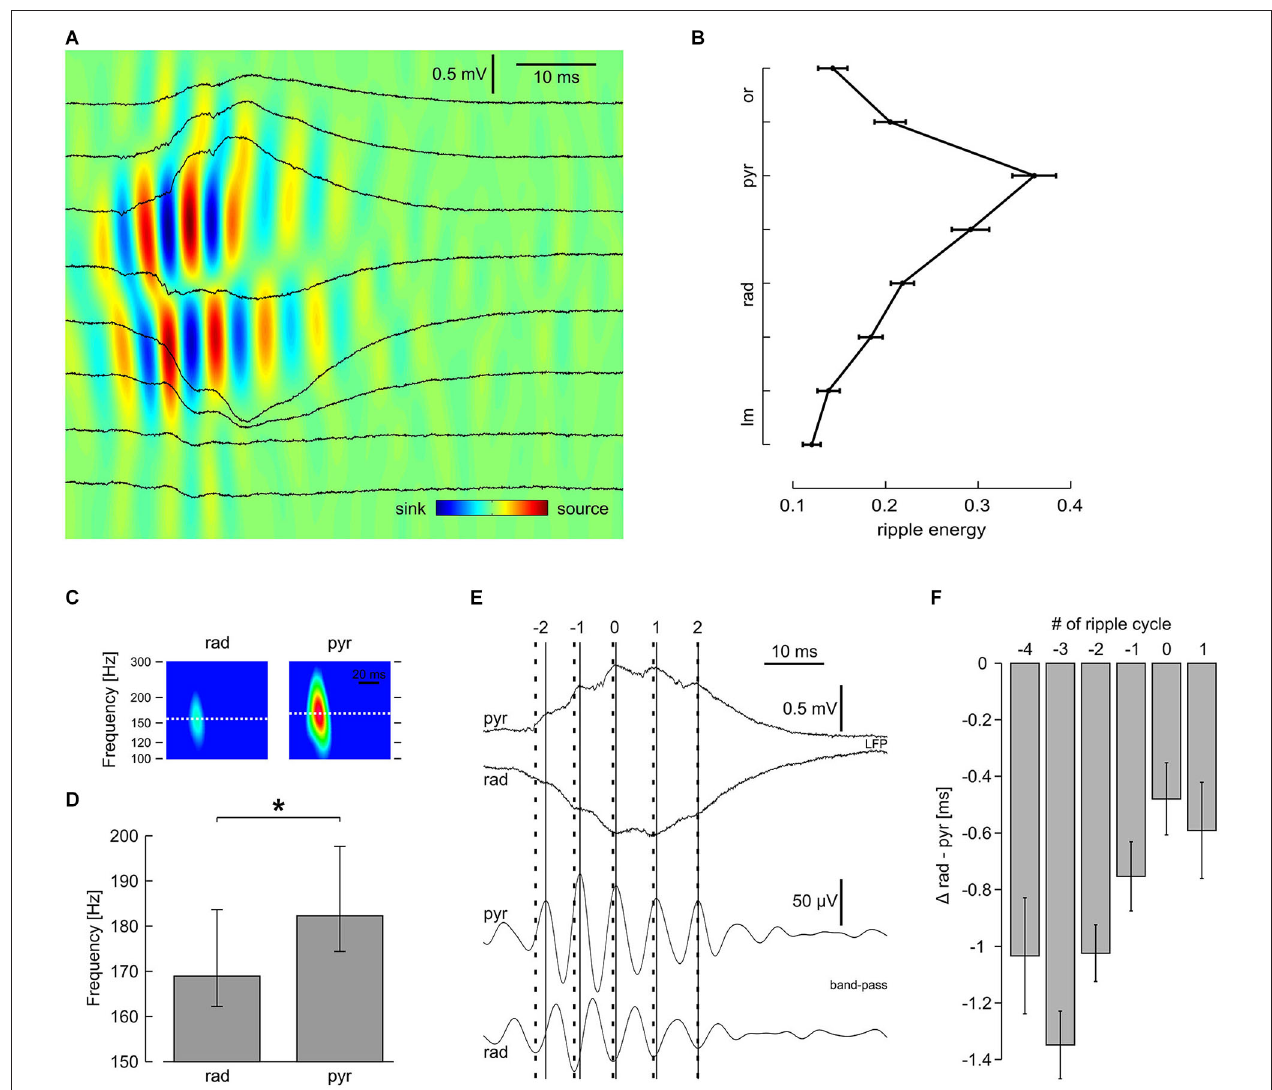
filtered traces, representative of s. pyramidale and s. radiatum, showing one SPW-R. Note that the interval between ripple troughs in s. pyramidale (solid lines) and corresponding peaks in s. radiatum (bold dashed lines) decreases during the course of this SPW-R. Index 0 is ascribed to the ripple trough left of the sharp wave peak detected in s. pyramidale. (F) Average phase lag of high-frequency oscillation in s. radiatum in relation to s. pyramidale, mean and SEM of n = 51 slices. Regression line for cycle # − 4 to #1: average slope 0.16 ms per cycle, r 2 0.074, P < 0.01; cycle # − 3 to #0: average slope 0.29 ms per cycle, r 2 0.13, P <